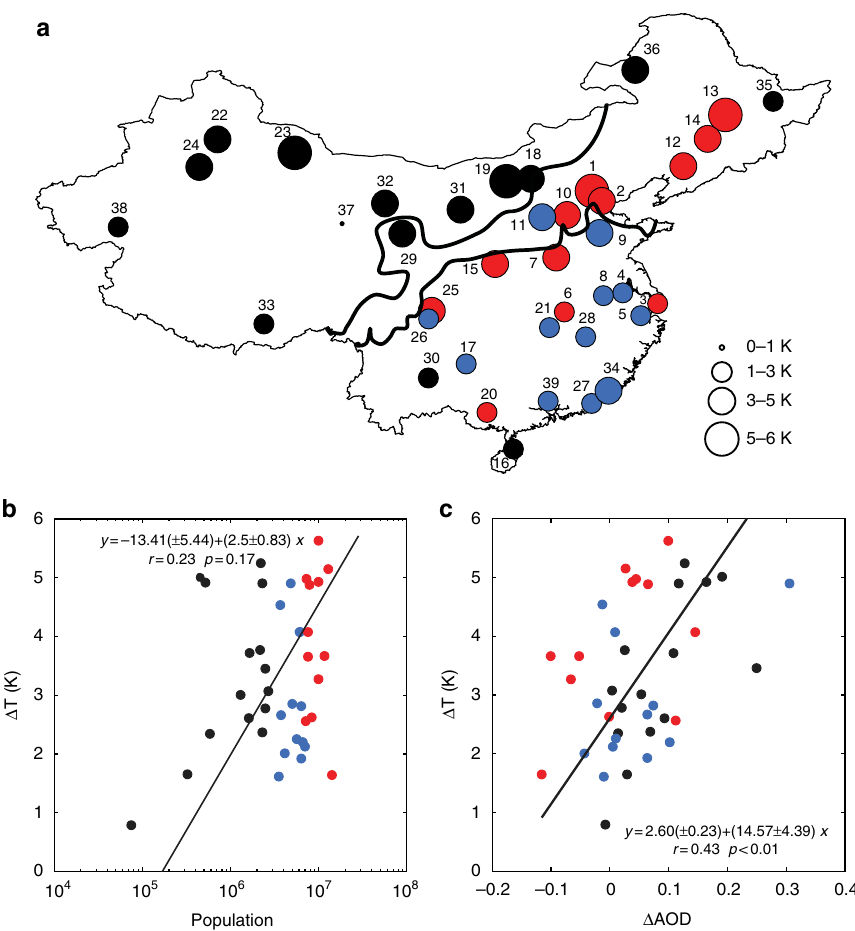
Figure 1 | Nighttime MODIS surface urban heat island intensity in mainland China from 2003 to 2013. ( a ) Spatial variation of the annual-mean nighttime MODIS-derived surface Urban Heat Island (UHI) across mainland China (K). ( b ) Surface UHI intensity relationship with population. ( c ) Surface UHI dependence on urban–rural AOD difference. Red, blue and black circles indicate large (population 4 7 million), medium (3–7 million) and small cities ( o 3 million), respectively. The two thick lines in a mark the boundary of three Ko¨ppen–Geiger climate zones (humid, semi-humid and semi-arid from south to north). Lines in b , c are linear regression with regression statistics noted. Errors on the regression parameters are 95% confidence